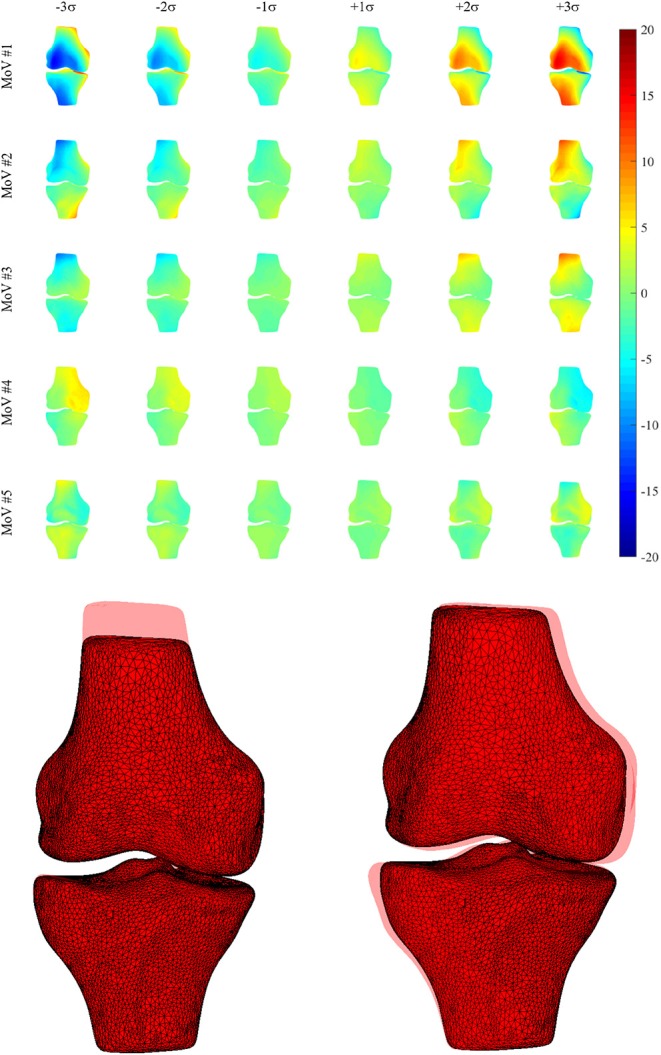
(Upper) Morphological deviations (mm) from the mean model (frontal view) for MoVs from #1 to #5. (Lower) Explicit morphology in two SSM parameter sets (MoV #3 -3σ, MoV #4 +3σ) with the overlaid mean model.